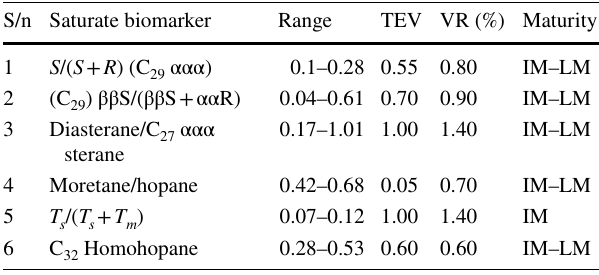
Table 6 Selected saturate biomarker maturity indices of coal and shale sample of Maiganga, Gombe Formation